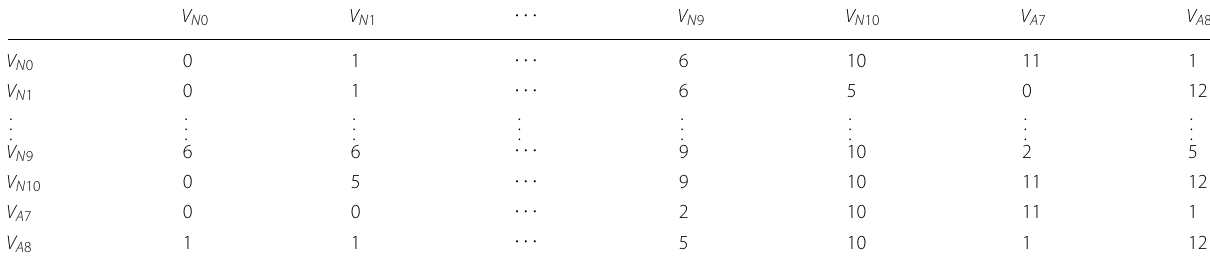
Table 5 Path matrix after NFZ